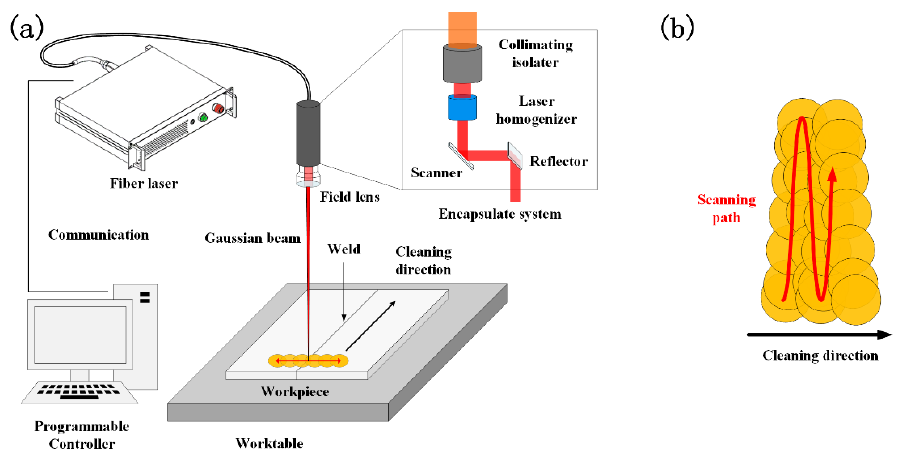
Figure 1. ( a ) Schematic of laser cleaning system and ( b ) the scanning path of the beam. Table 1. Main parameters of laser cleaning.